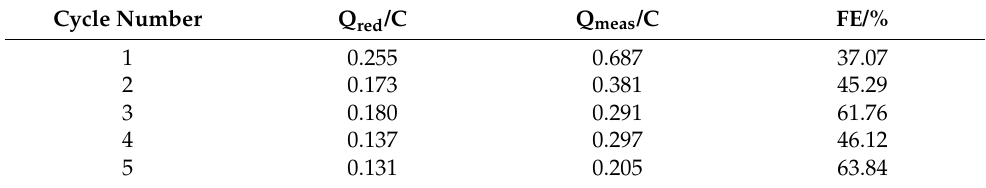
Table 3. Faraday efficiency of electrochemical oxidation reaction during desorption process of CoHCF thin